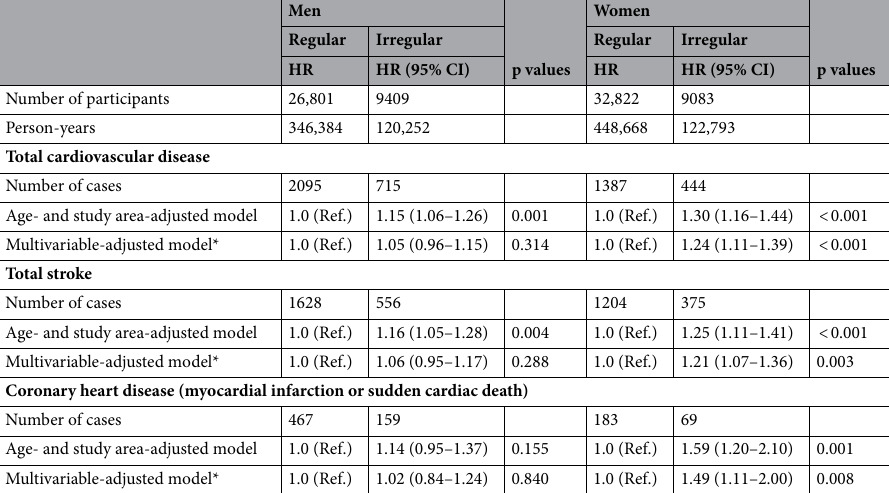
Table 2. Age- and study area-adjusted and multivariable-adjusted hazard ratios and 95% confidence intervals of incident cardiovascular diseases according to self-reported irregular daily routine. *Adjusted by age and study area, quartile of BMI, living arrangement, alcohol intake, cigarette smoking status, perceived mental stress, working hours, job type, frequency of eating breakfast, sleep duration, quartile of METs, energy intake, energy-adjusted dietary intakes of vegetables, fruits, meat, fish, and sodium. HR hazard ratio, CI confidence interval, BMI body mass index, MET metabolic equivalent